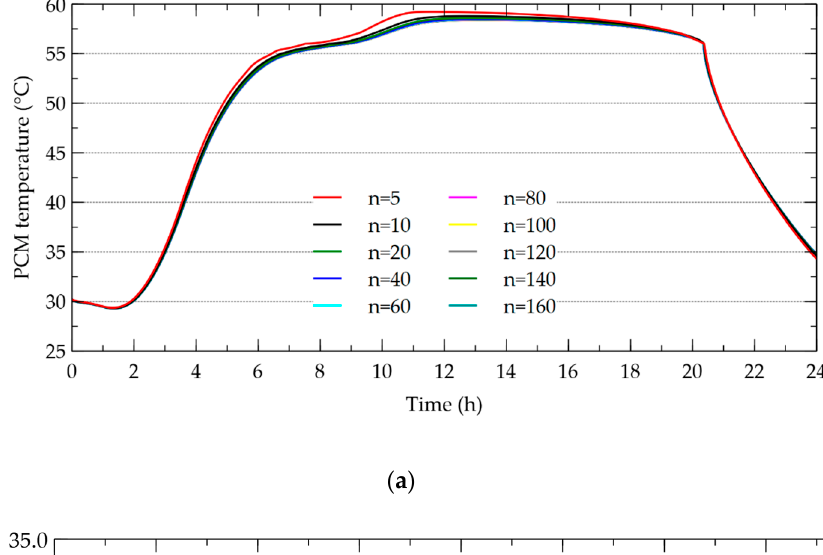
Figure 5. Independent analysis for PCM layers: ( a ) Simulations for different numbers of PCM layers. ( b ) Temperature at 24:00 h for different numbers of PCM layers.